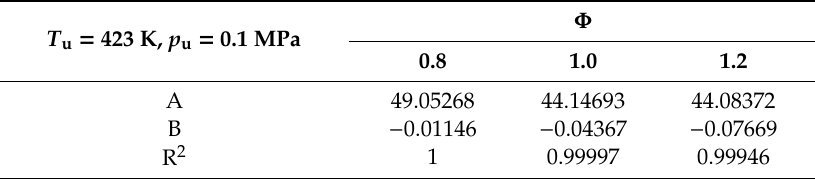
Table 6. Coe ffi cients of the linear fit to the data of laminar burning velocity versus maximum mole fraction of H + OH under di ff erent dilution